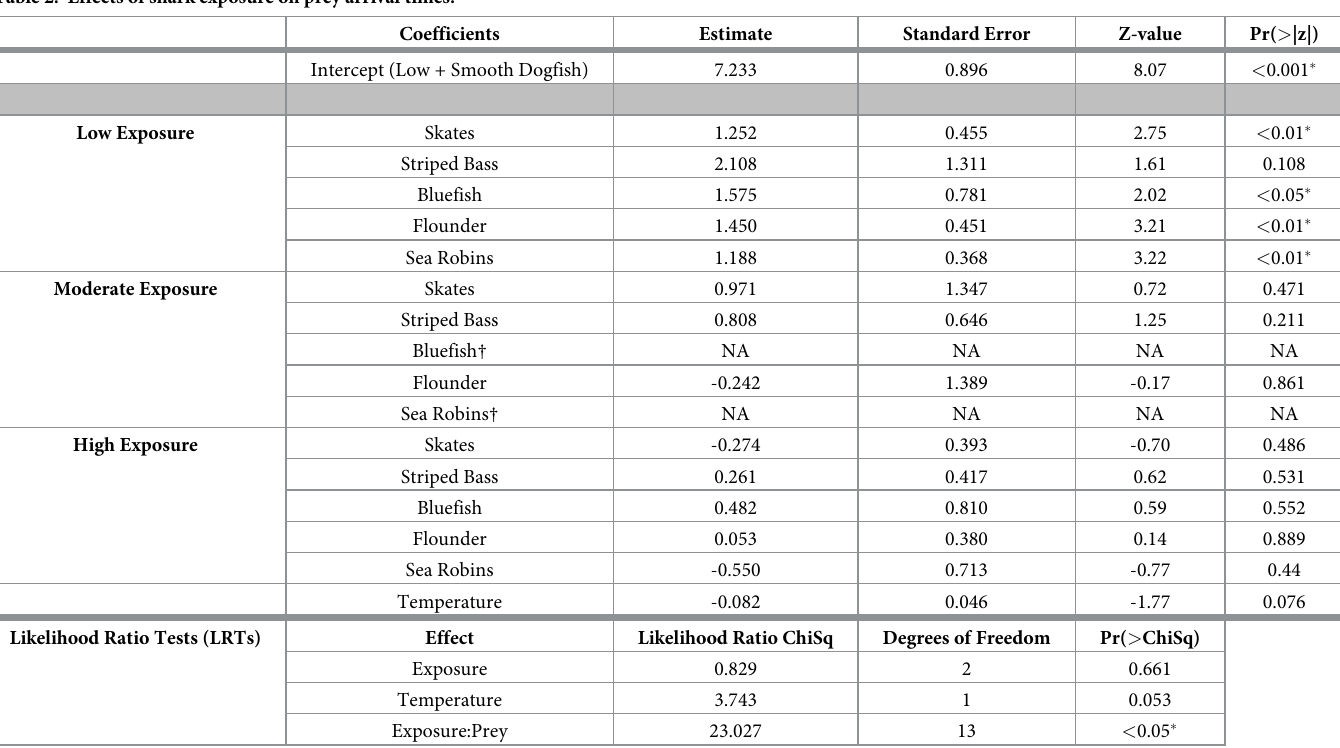
Table 2. Effects of shark exposure on prey arrival